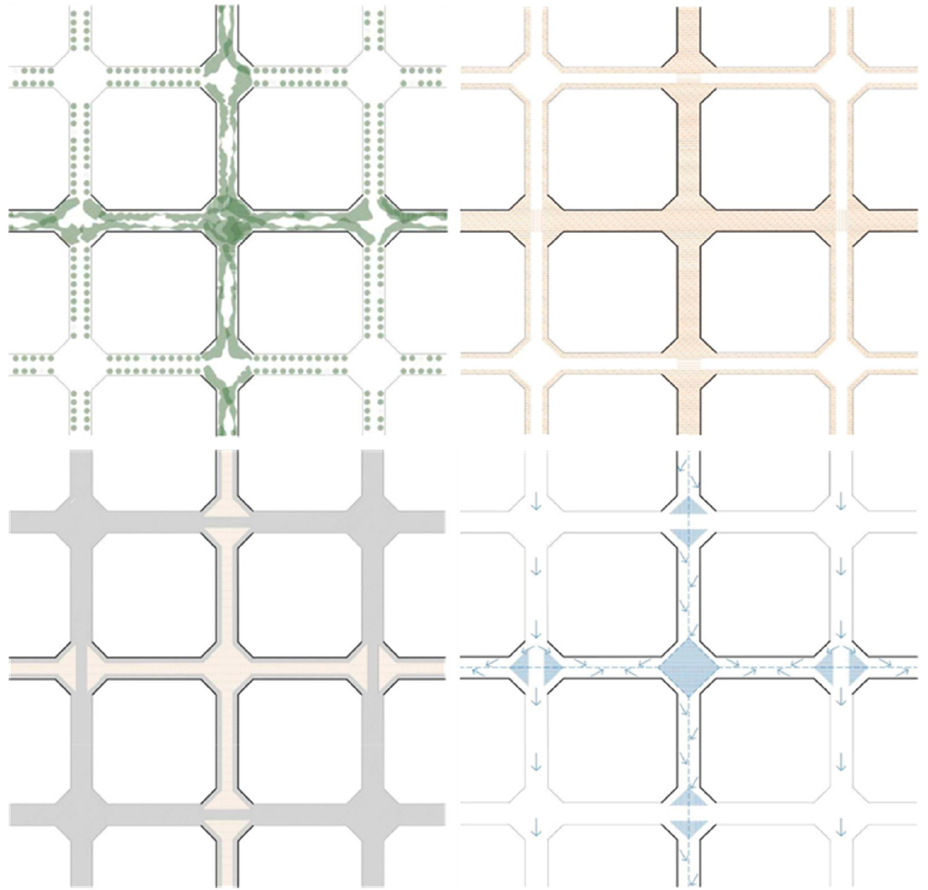
Figure 12. Main actions for the configuration of green axes as green infrastructure and active mobility. In the subsoil, distribution of soil for continuity of roots ( bottom-left ) and rainwater filtration ( bottom-right ). On the ground, priority area for active mobility and stationary activities ( top-right ). At the aerial level, development of trees and other plant species ( top-left ). Source: Ajuntament de Barcelona